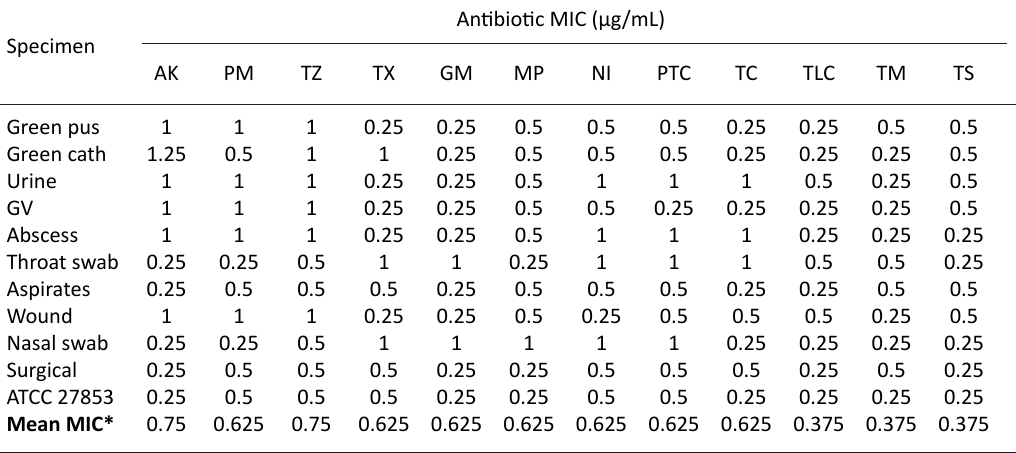
Table 2. Comparison of Pseudomonas aeruginosa susceptibility to standard antibiotics determined as minimum inhibitory concentrations in